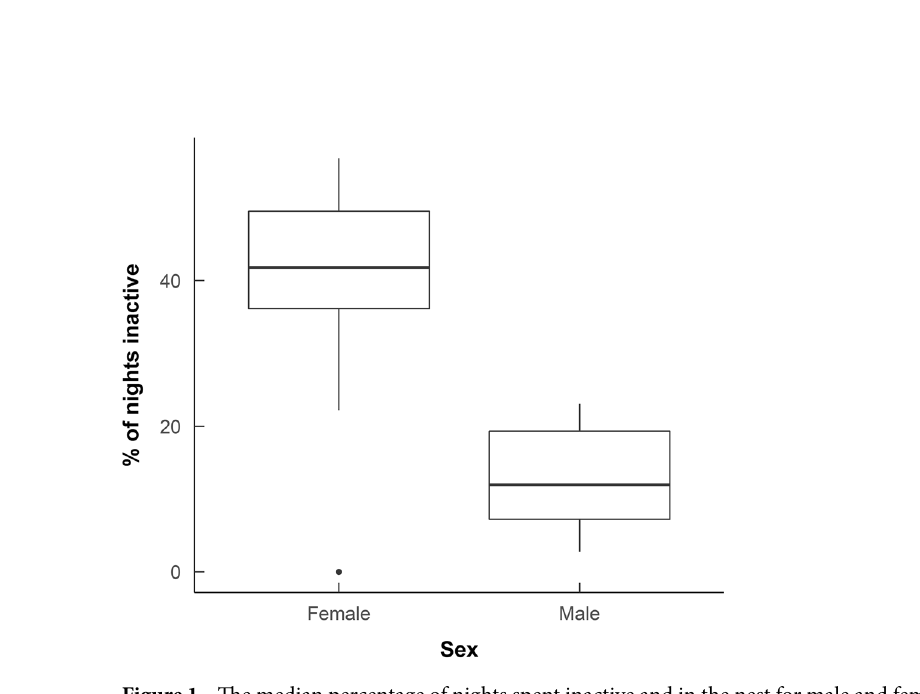
Figure 1. The median percentage of nights spent inactive and in the nest for male and female desert hedgehogs over winter in Qatar. The percentage was calculated by dividing the number of nights inactive divided by the total number of nights tracked over winter. Data includes 20 individuals, radio-tracked from November 2010 to February in 2011 and November 2011 to February 2012. Lower and upper hinges show the interquartile range. Whiskers show values within 1.5 times the interquartile range, dots are outliers to